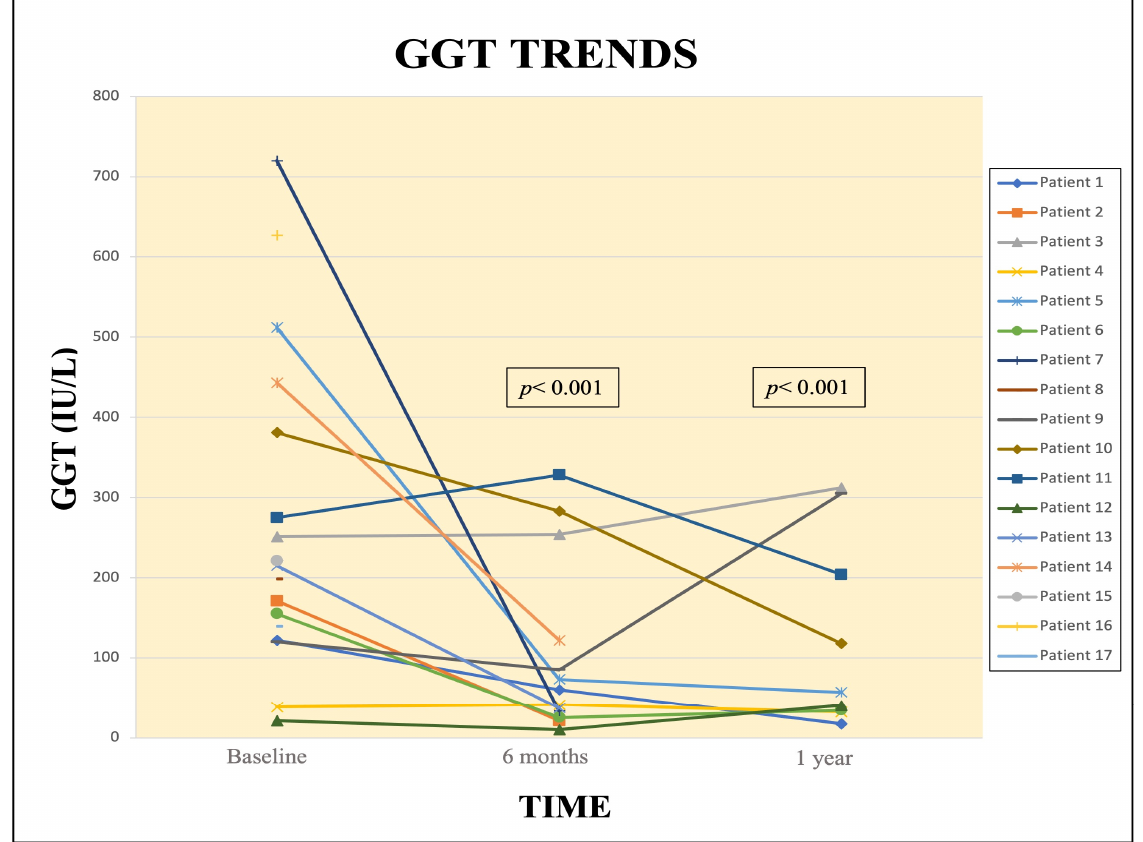
Figure 3. Gamma Glutamyl Transferase (GGT) Trends at baseline, 6 months and 1 year after initiation of Oral Vancomycin Therapy (OVT), p < 0.001.